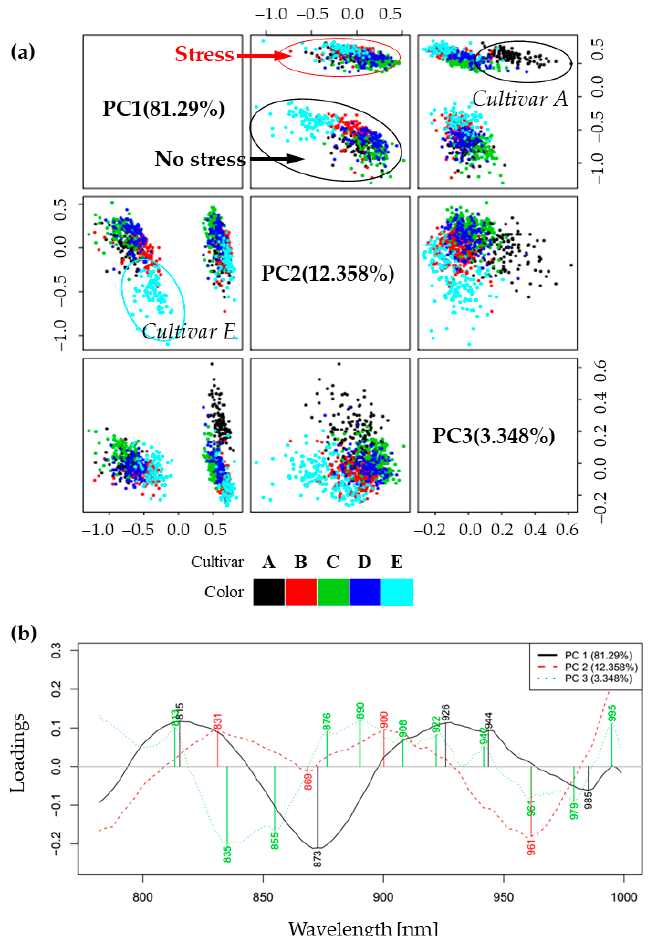
Figure 2. Principal component analysis results: ( a ) Score plots for the first three components re- vealed separation of plants according to the growing conditions. Two large groups of scores in the PC1-PC2 space correspond to the spectra of plants in the optimal growing conditions and during cold stress. In the score plots PC1-PC3 and PC2-PC3, differences were observed between cultivar A and cultivar E, respectively, compared to the other cultivars; ( b ) loadings of the first three principal components describe 97% variation in the spectra. The loading of the PC1 describes variations in the spectra of plants’ leaves as a result of changes in the temperature of the growing environment, while the PC2 and PC3 loading show spectral characteristics that distinguish cultivar E and cultivar A, respectively, compared to the other cultivars.